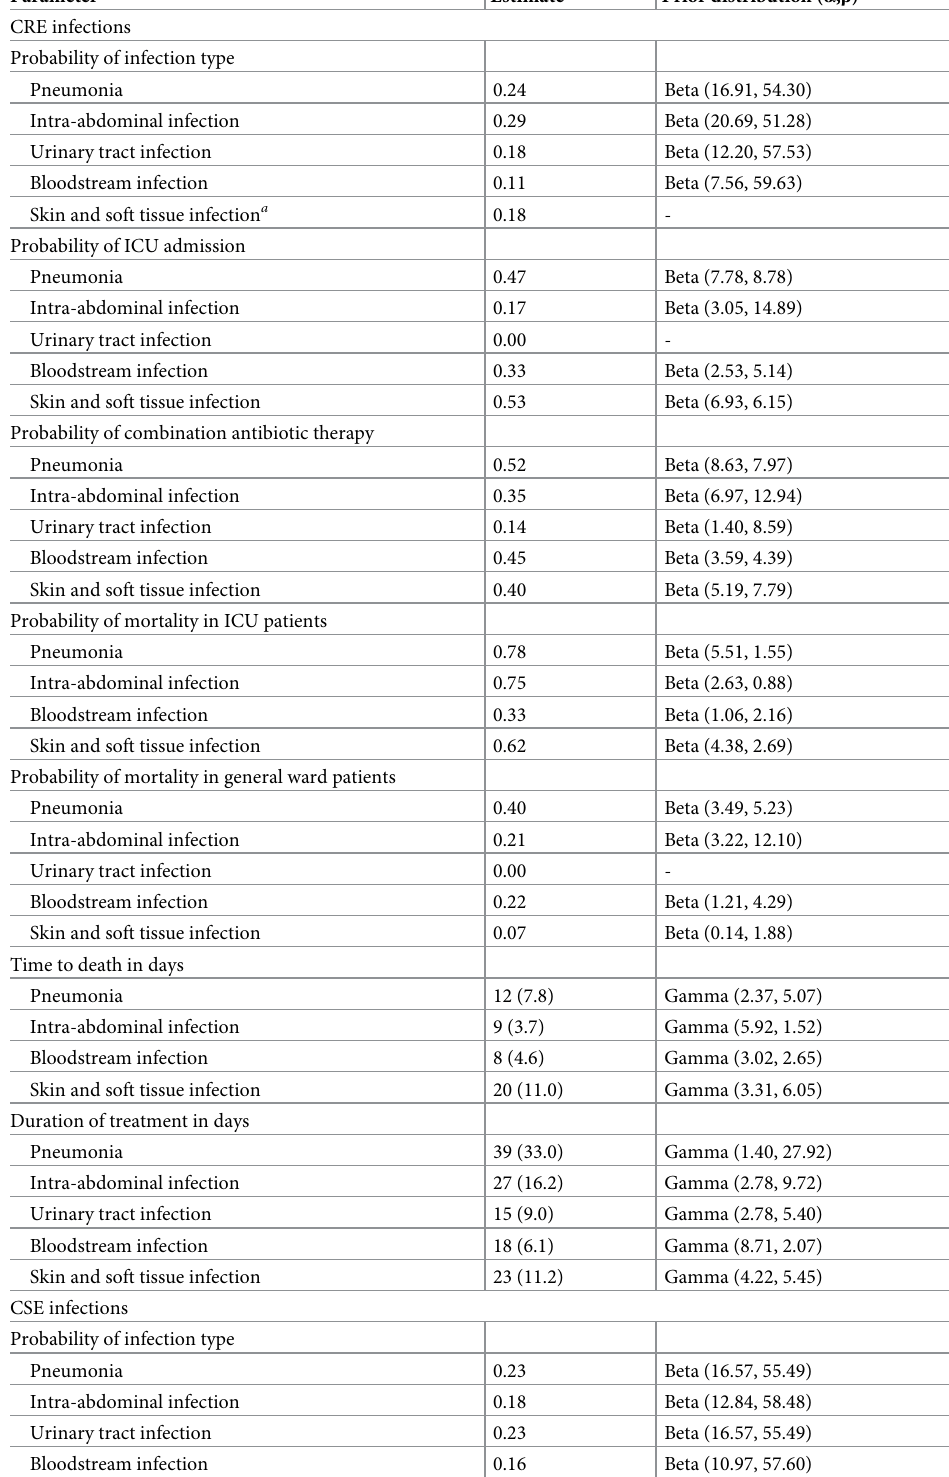
Table 1. Model input for probabilities and outcomes